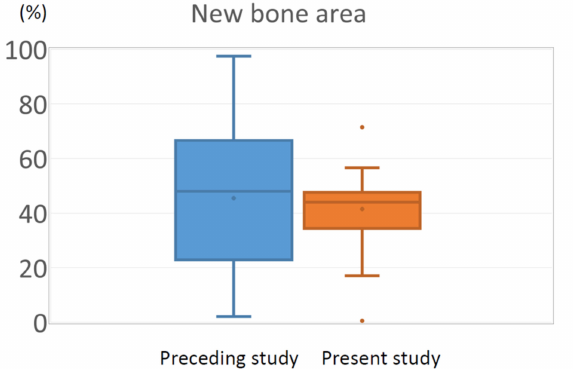
Figure 9. Box-and-whisker plot showing the distribution of new bone area in the previous and present studies. Note the variation was considerably improved in the present study.